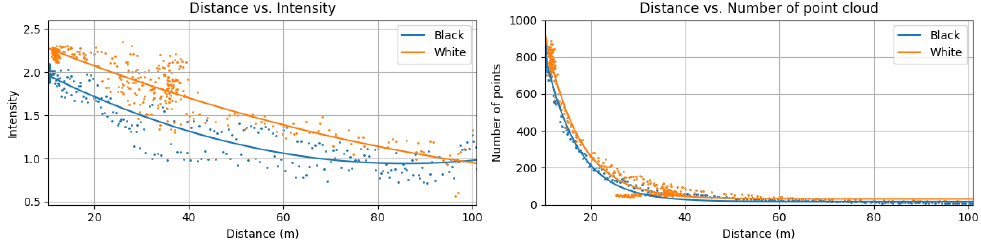
Figure 13. ( Left ) mean intensity of captured points from black/white car according to the distance ( Right ) number of captured points from black/white car according to the